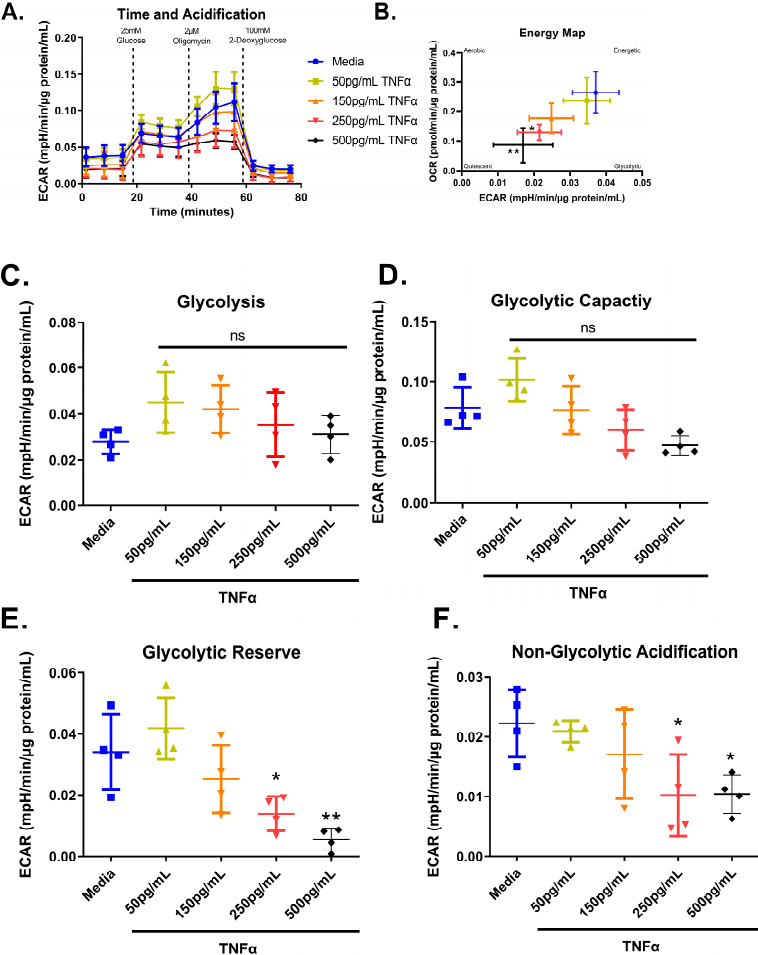
Figure 8. Normalized extracellular acidification rate for primary rat colon epithelial cells after 24- hour exposure to TNF α . ( A ) Acidification rates over time, ( B ) energy map, ( C ) glycolysis, ( D ) gly- colytic capacity, ( E ) glycolytic reserve, and ( F ) non-glycolytic acidification. Data are presented as mean ± standard deviation. Asterisks indicate degree of significance from medium control (One- way ANOVA followed by a Dunnett’s multiple comparison test, n = 3 or 4; significance determined at * = p < 0.05, ** = p < 0.01).